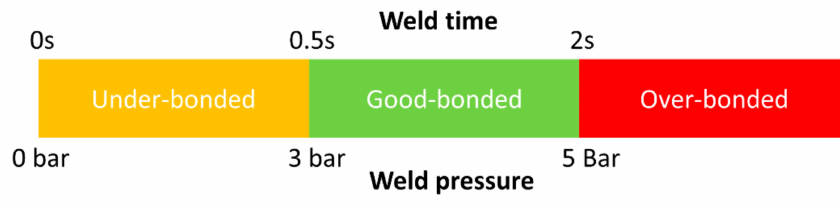
Figure 8. E ff ect of near and far-field weld parameters on the bonding of ED integrated panels.